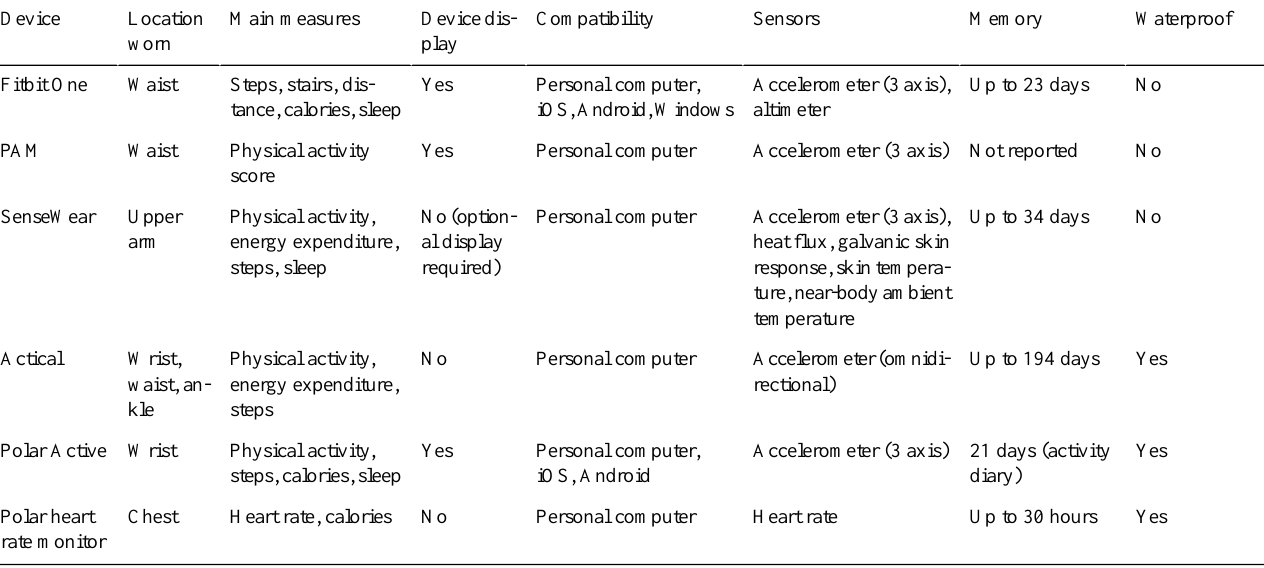
Table 2. Overview of features of wearable devices used in the included studies on the effectiveness and feasibility of wearable activity trackers in youth.